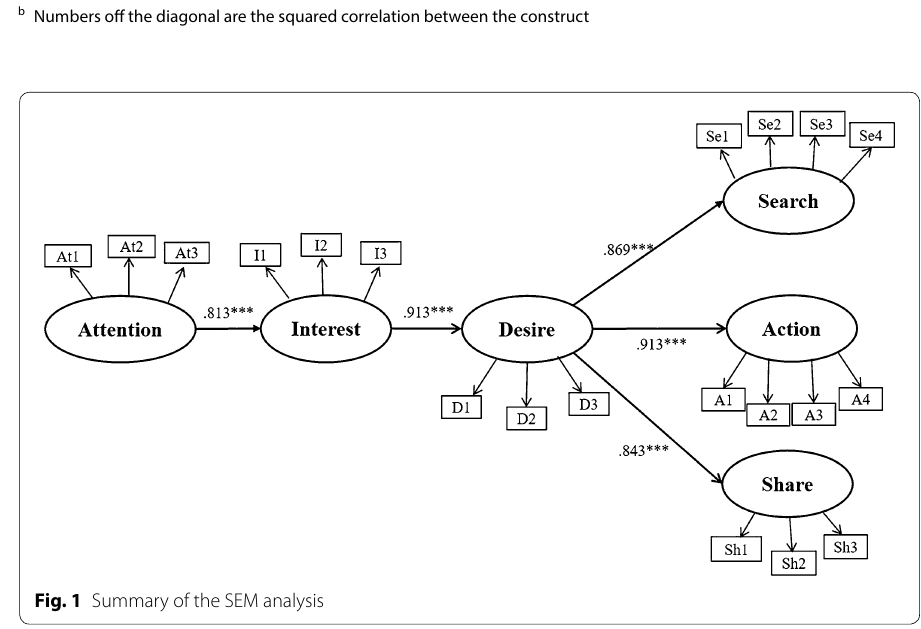
a Numbers on the diagonal are AVE b Numbers off the diagonal are the squared correlation between the construct